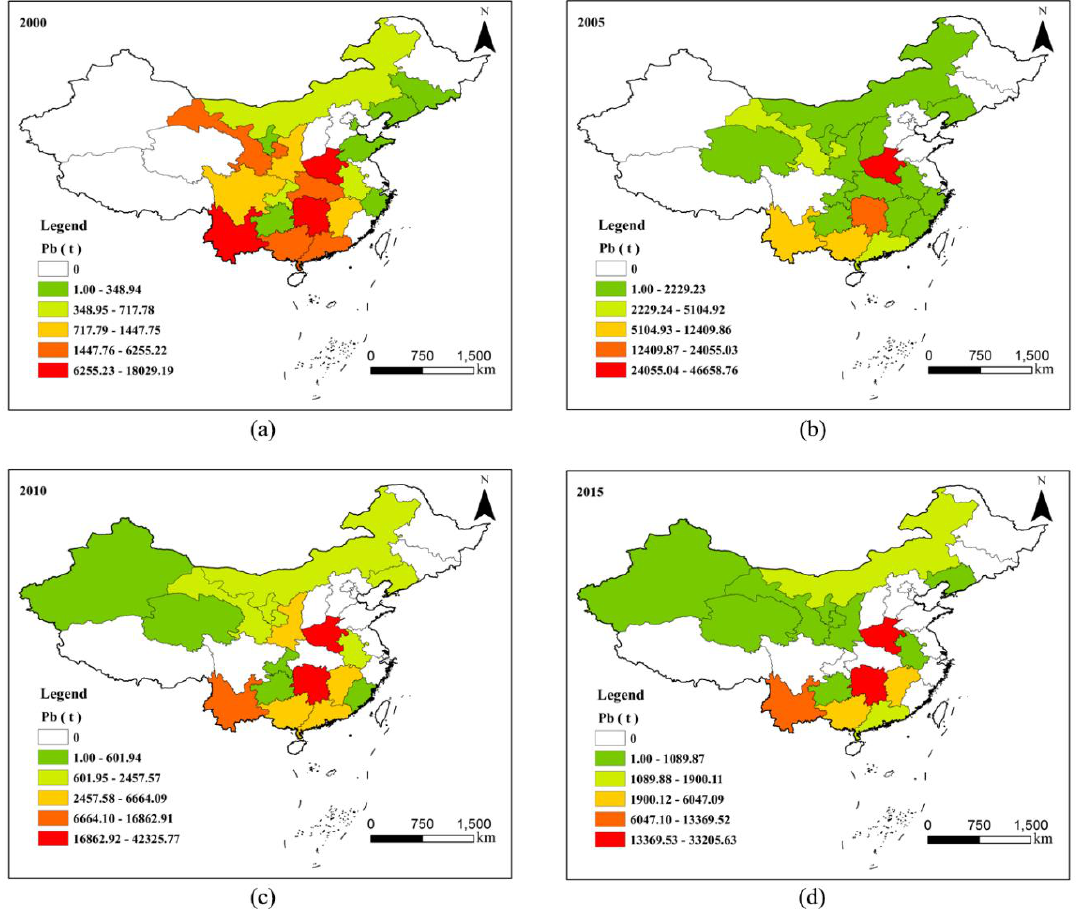
Figure 2. Spatial distribution characteristics of Pb environmental release in China. ( a ) spatial distribution of Pb in 2000; ( b ) spatial distribution of Pb in 2005; ( c ) spatial distribution of Pb in 2010; ( d ) spatial distribution of Pb in 2015.